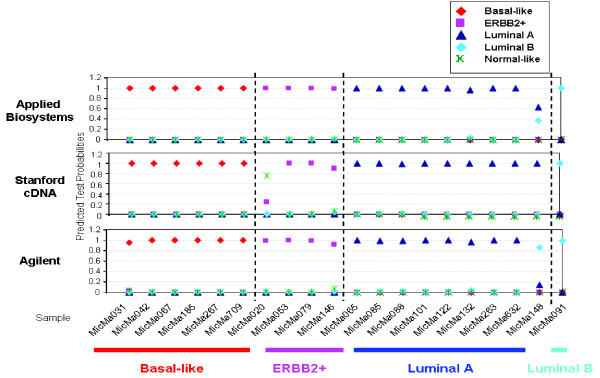
Prediction of tumor subtype by Prediction Analysis of Microarrays (PAM). 428 genes were selected at a threshold of 1.0 that separated the two subtypes with the lowest overall misclassification rate of 5% (data not shown). Predicted probabilities of subtype for each tumor sample analyzed on Applied Biosystems Human Genome Survey Microarrays (top panel), Stanford Human cDNA arrays (middle panel) and Agilent Whole Human Genome Microarrays (bottom panel) were computed using the predictive model built using these 428 predictor genes.